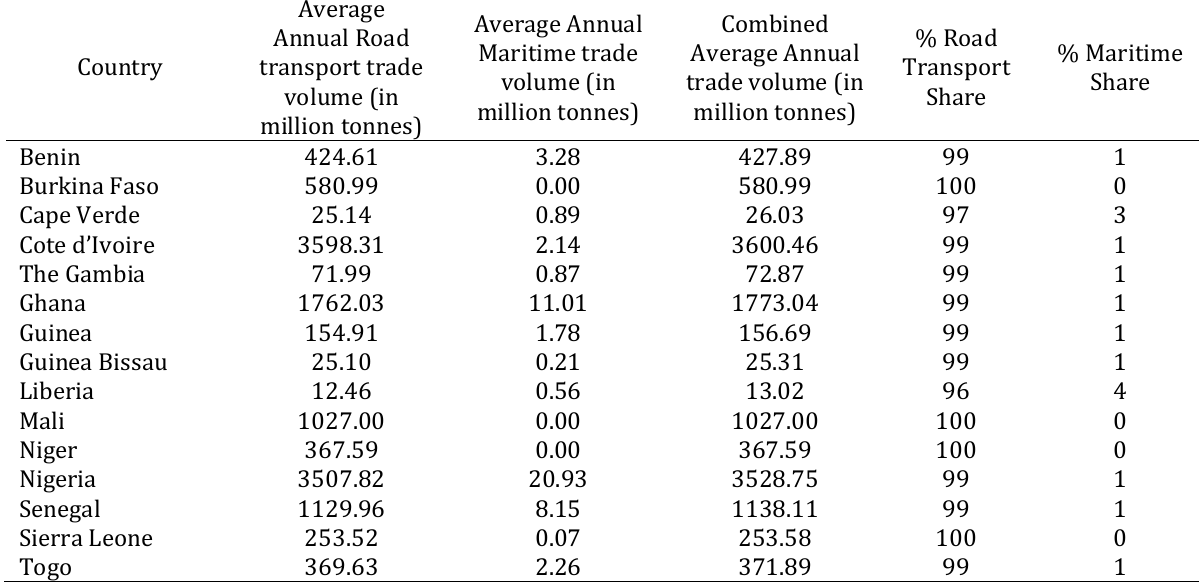
Table 4: Modal Share of Freight Volumes in ECOWAS Nations from 2000-2013